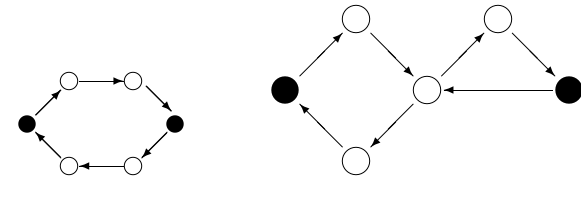
Fig. 4: The two possible subgraphs for γ ( G ) = 2